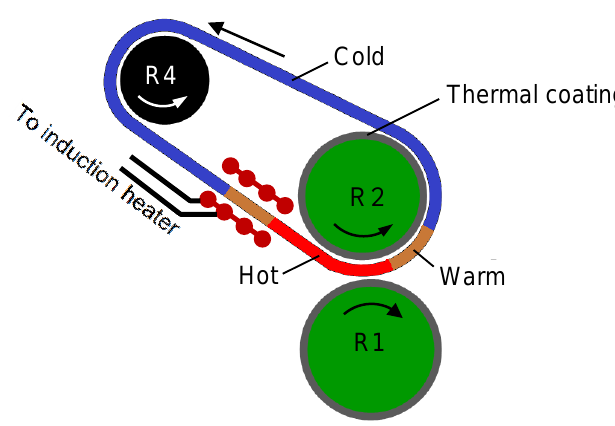
Figure 3. Induction heating of belt